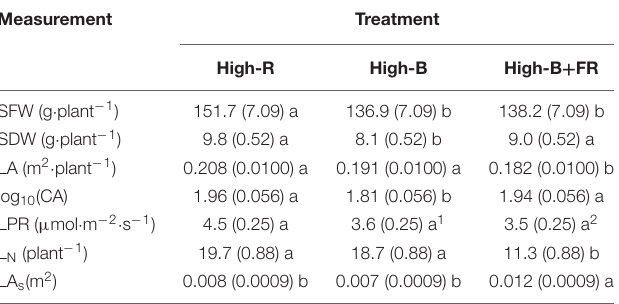
TABLE 2 | Effect of different light treatments (see Table 1 for treatment description) on shoot fresh weight (SFW), shoot dry weight (SDW), leaf area (LA), canopy area (CA), leaf photosynthesis rate (LPR), leaf number (L N ), and average area of a single leaf (LA s ) in green romaine